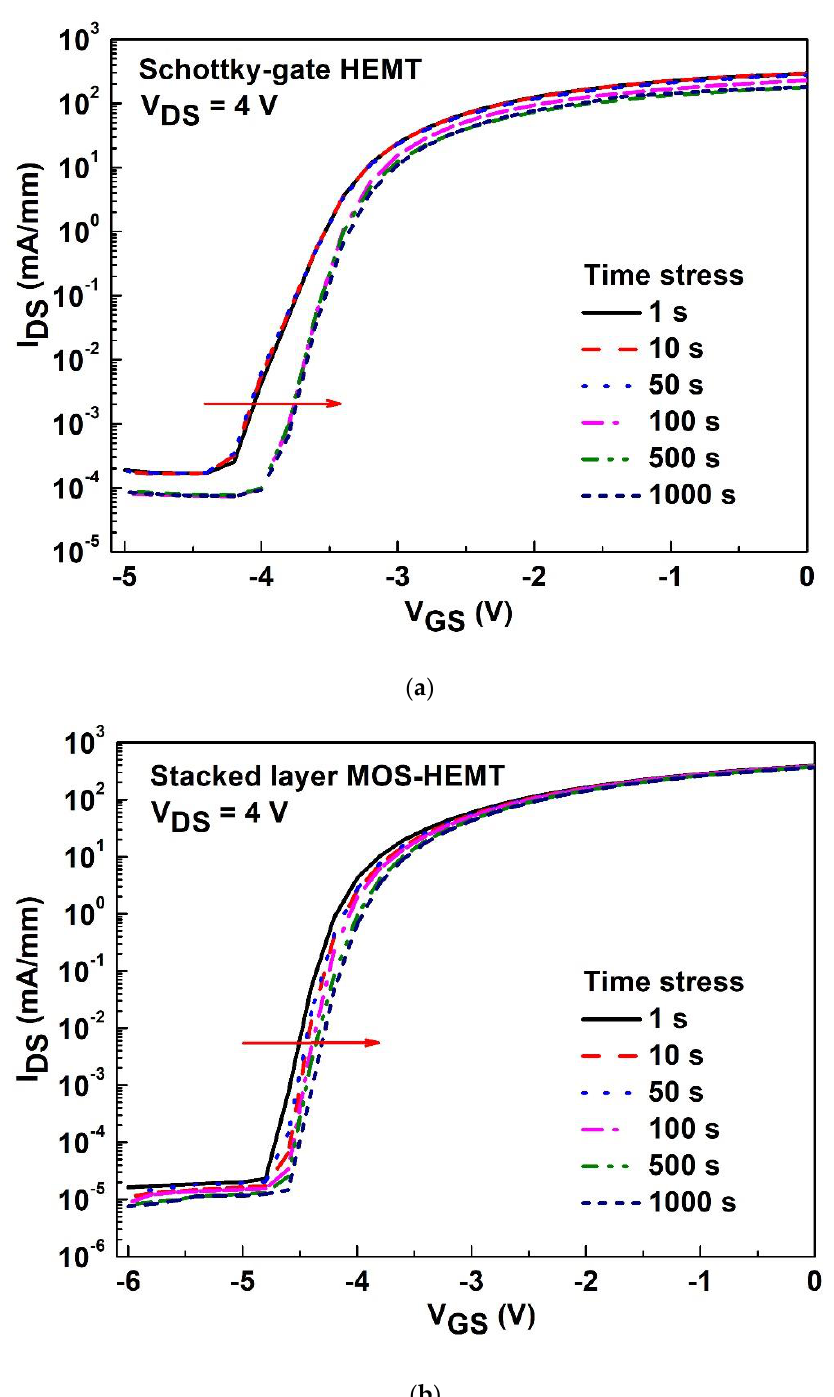
Figure 10. Subthreshold characteristics after stress at V GS of 1 V and V DS of 4 V with different stress time ranged from 1 s to 1000 s at room temperature for ( a ) the Schottky-gate HEMT and ( b ) the stacked-layer MOS-HEMT.